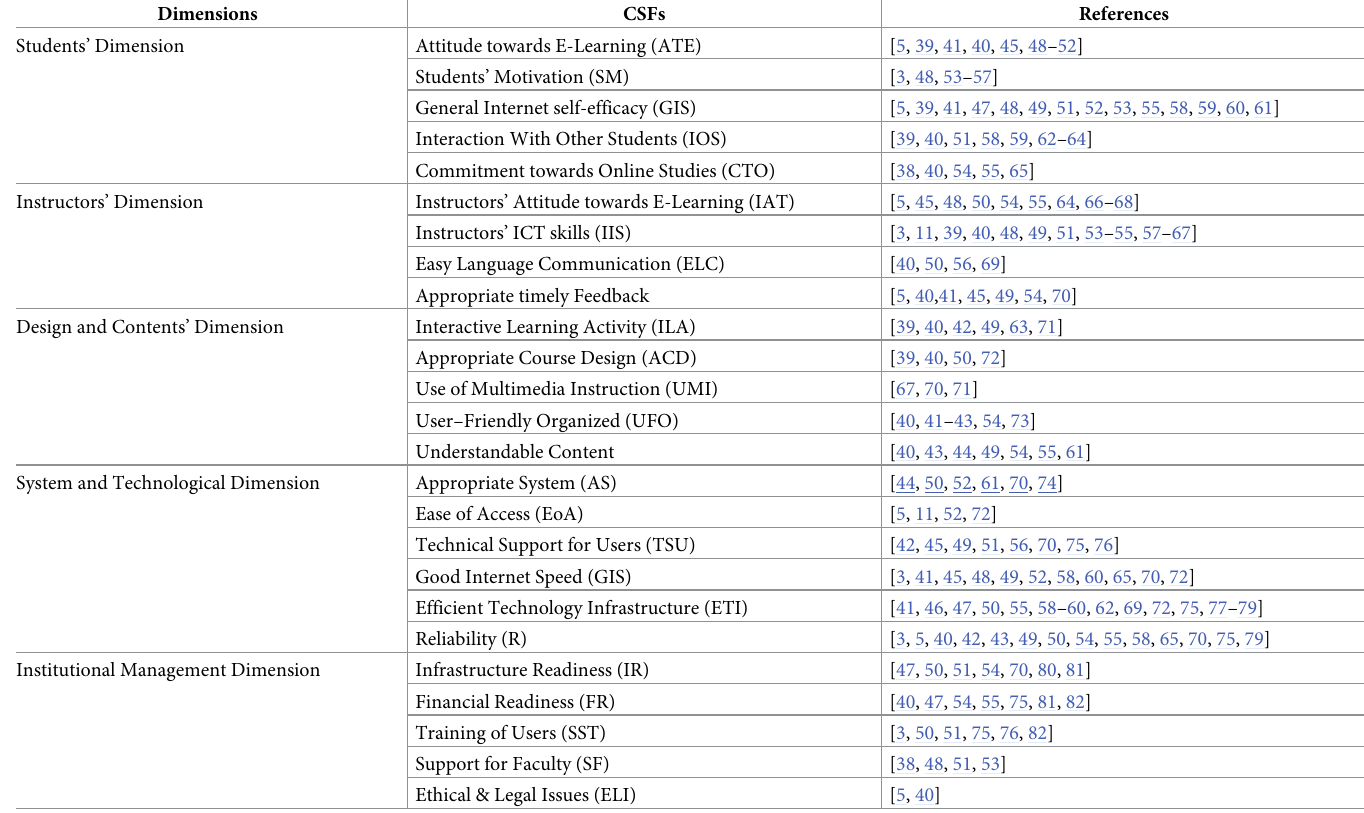
Table 1. Dimensions and CSFs of